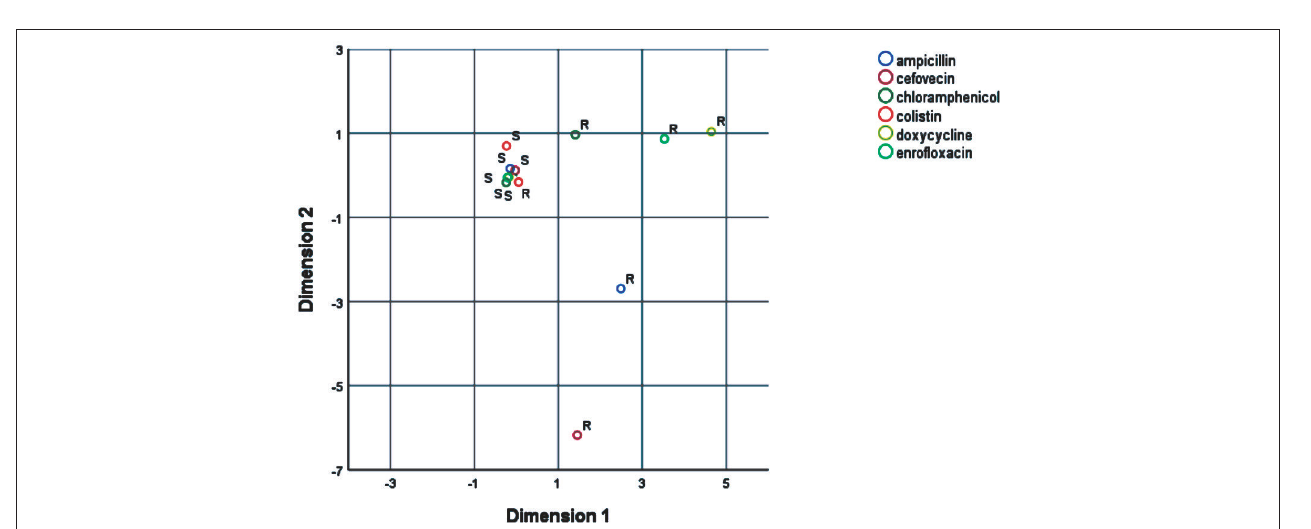
5%), tetracycline (44 vs. 15%), sulphonamides (59 vs. 22%),